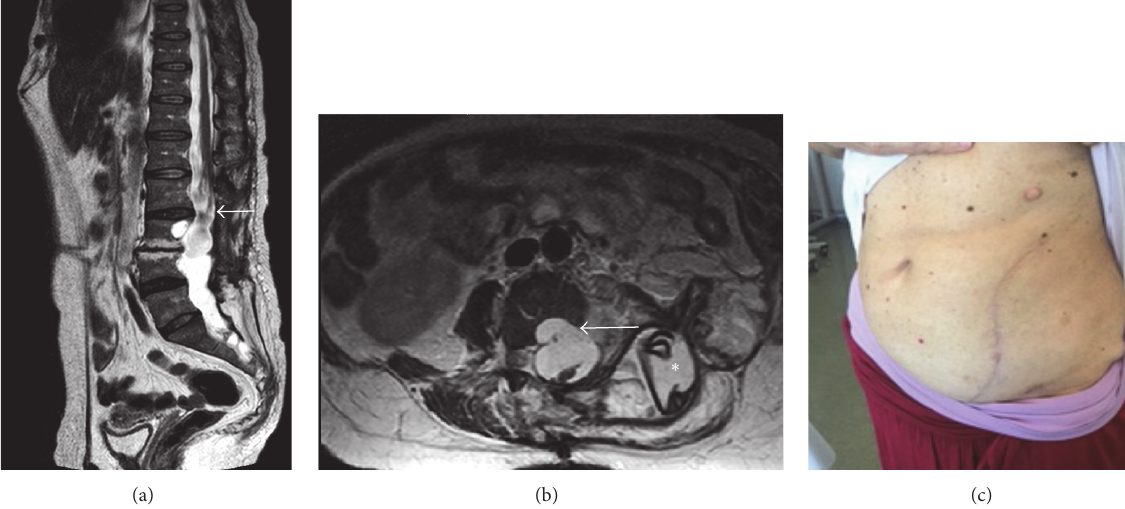
Figure 5: After six months, the patient was fine without neurological deficit or abdominal symptoms and the spinal sagittal and axial T2- weighted MRIimages showed norelapse ofthepseudomeningocele (a and b). Thesagittal T2-weighted MRIdemonstrated thedecompression of cauda roots (white arrows), even if appeared clumped together due to postsurgical scar. In the axial T2-weighted MRI the residual meningocele (white arrow) and the ADM (asterisk) with fat patch were demonstrated. The surgical incision completely healed was shown in image